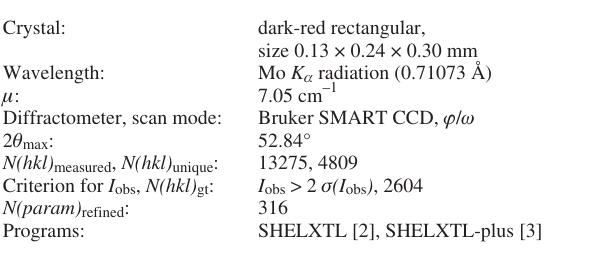
Table 1. Data collection and handling.